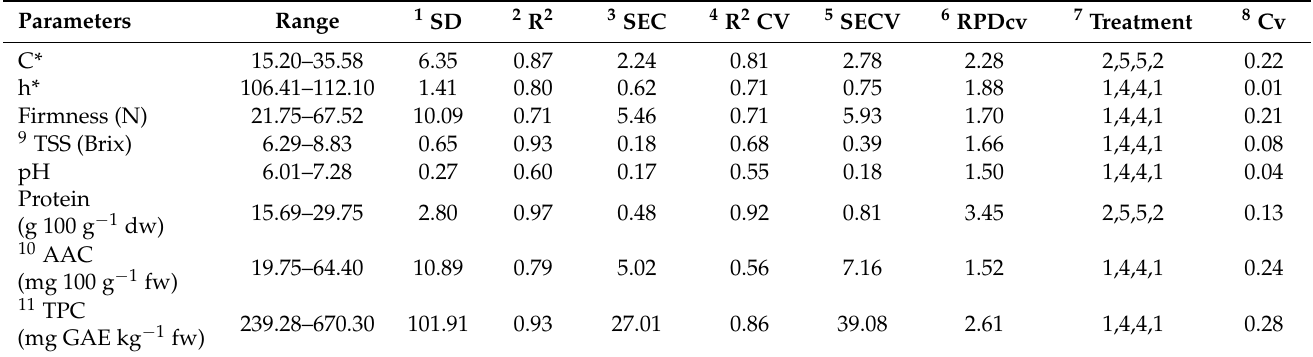
Table 3. Calibration and cross-validation statistics of quality compounds for mangetout.